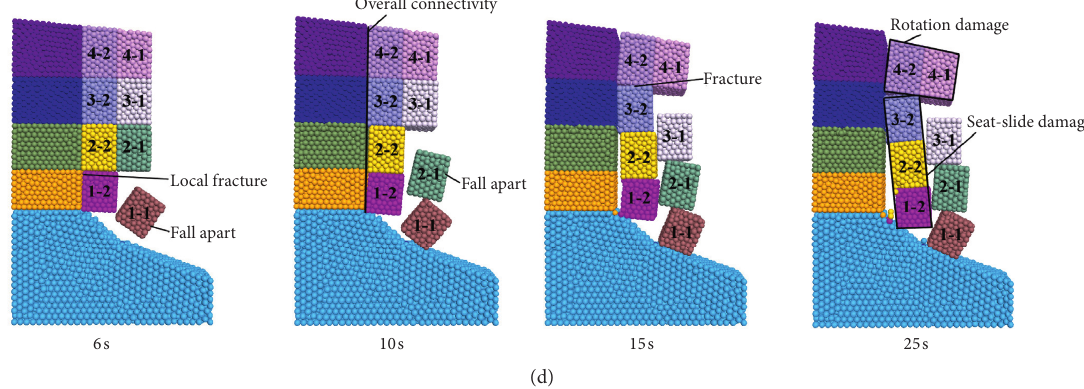
Figure 12: The destruction process diagram of each model. (a) Model 1. (b) Model 2. (c) Model 3. (d) Model